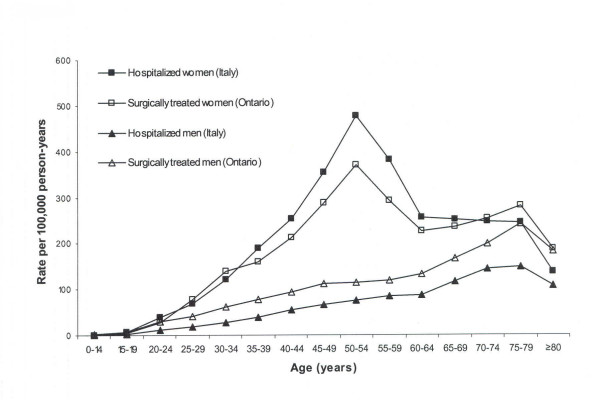
Age-sex-specific rates of in-hospital CTS in the present study, as compared with rates reported for Ontario in 1988[7].